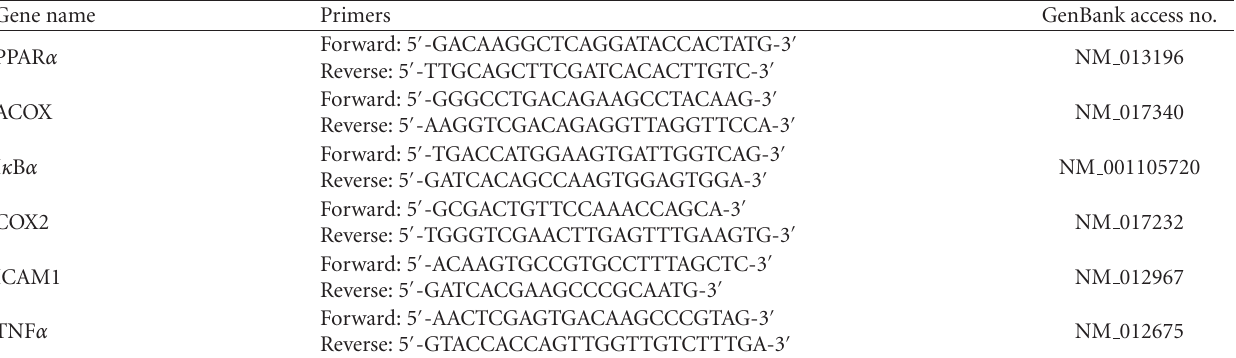
Table 2: Primer sequences for quantitative real-time PCR